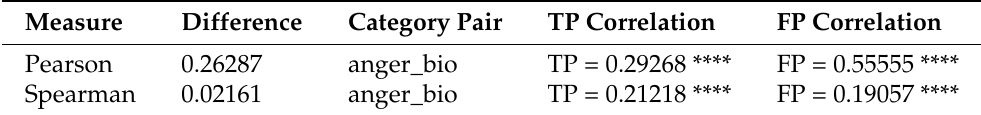
Table 28. Anger and Bio in